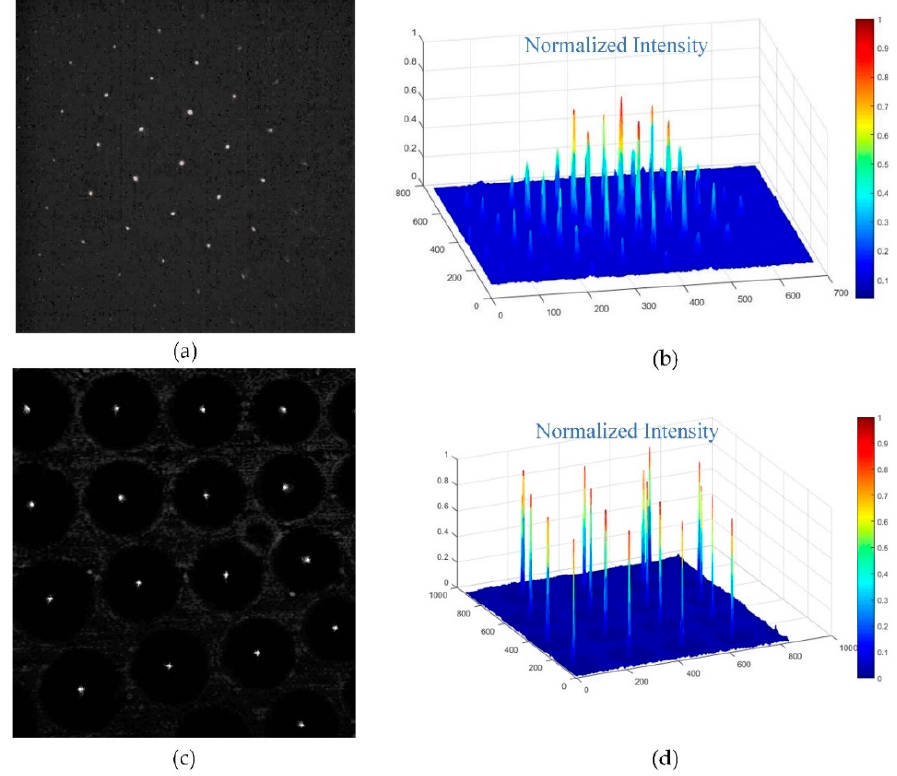
Figure 8. Focal spots of compound eyes with single and multiple focal lengths: ( a ) focal spots of single focal length microlenses on dome area; ( b ) normalized intensity distribution of single focal length microlenses; ( c ) focal spots of multiple focal length microlenses on the middle area; ( d ) normalized intensity distribution of multiple focal length microlenses.